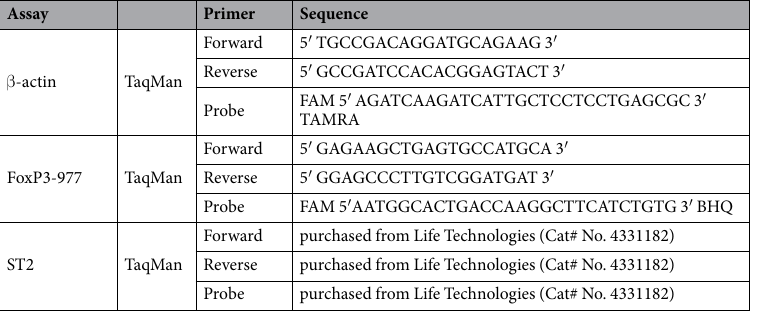
Table 3. Primer/probe sequences of house-keeping gene, ST2 and FoxP3 for quantitative real-time